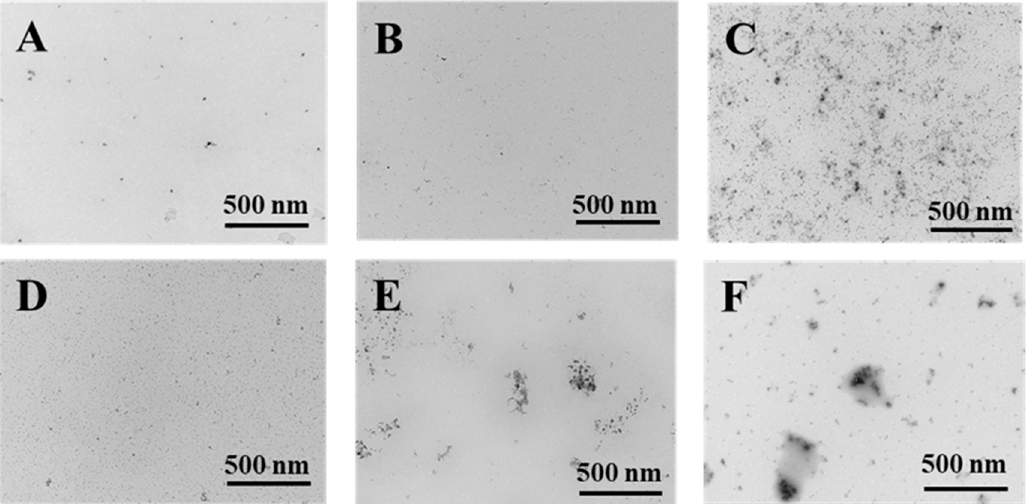
Figure 7. Transmission electron microscopy micrographs of PWP and PNS-PWP (1:30). PWP ( A ); PNS-PWP (1:30) ( B ); SGF-PWP ( C ); SGF-PNS:PWP (1:30) ( D ); SIF-PWP ( E ), and SIF-PNS:PWP(1:30) ( F ).